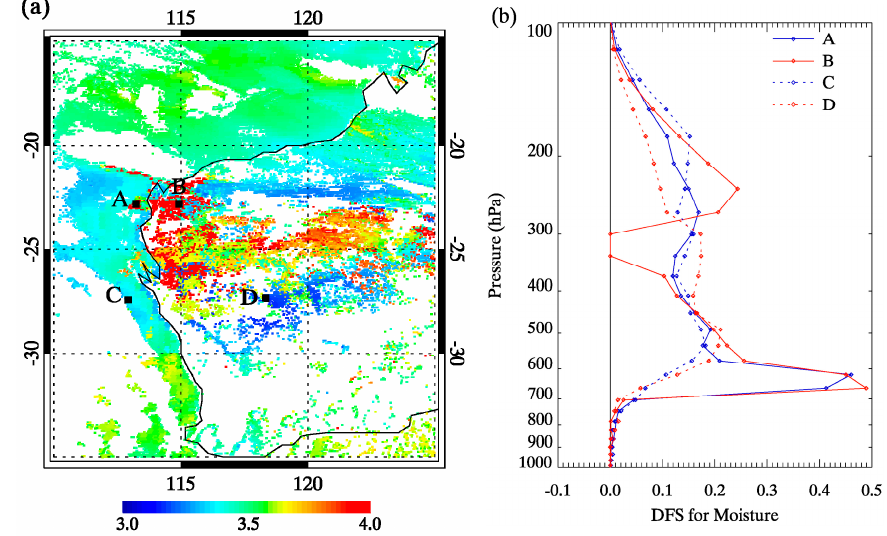
Figure 8 Figure 8. ( a ) the distribution of total DFS in the western part of Australia and ( b ) the profiles of Q DFS corresponding to the locations A, B, C and D in ( a